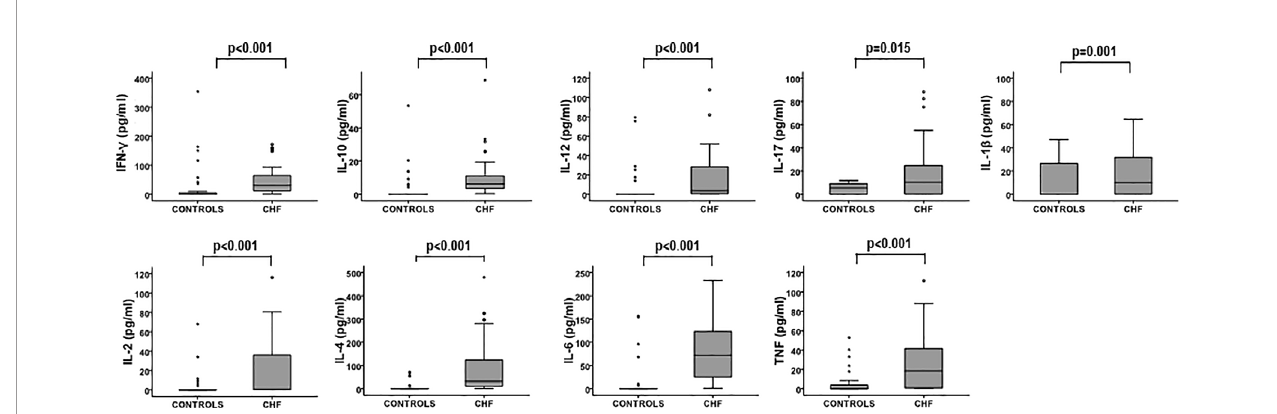
FIGURE 1 | Cytokine levels in the two studied groups. Cytokine concentrations were measured using Luminex multiplex technology. Levels of cytokines in CHF (n = 40) and controls (n = 40) are illustrated in the box plots. Differences between groups in the levels of cytokines were compared using the Mann-Whitney Test, p- values are depicted in the panels. Outlier values are represented by circles and extreme values by stars, calculated by adding 1.5 and 3 times the IR to the 75th percentile,